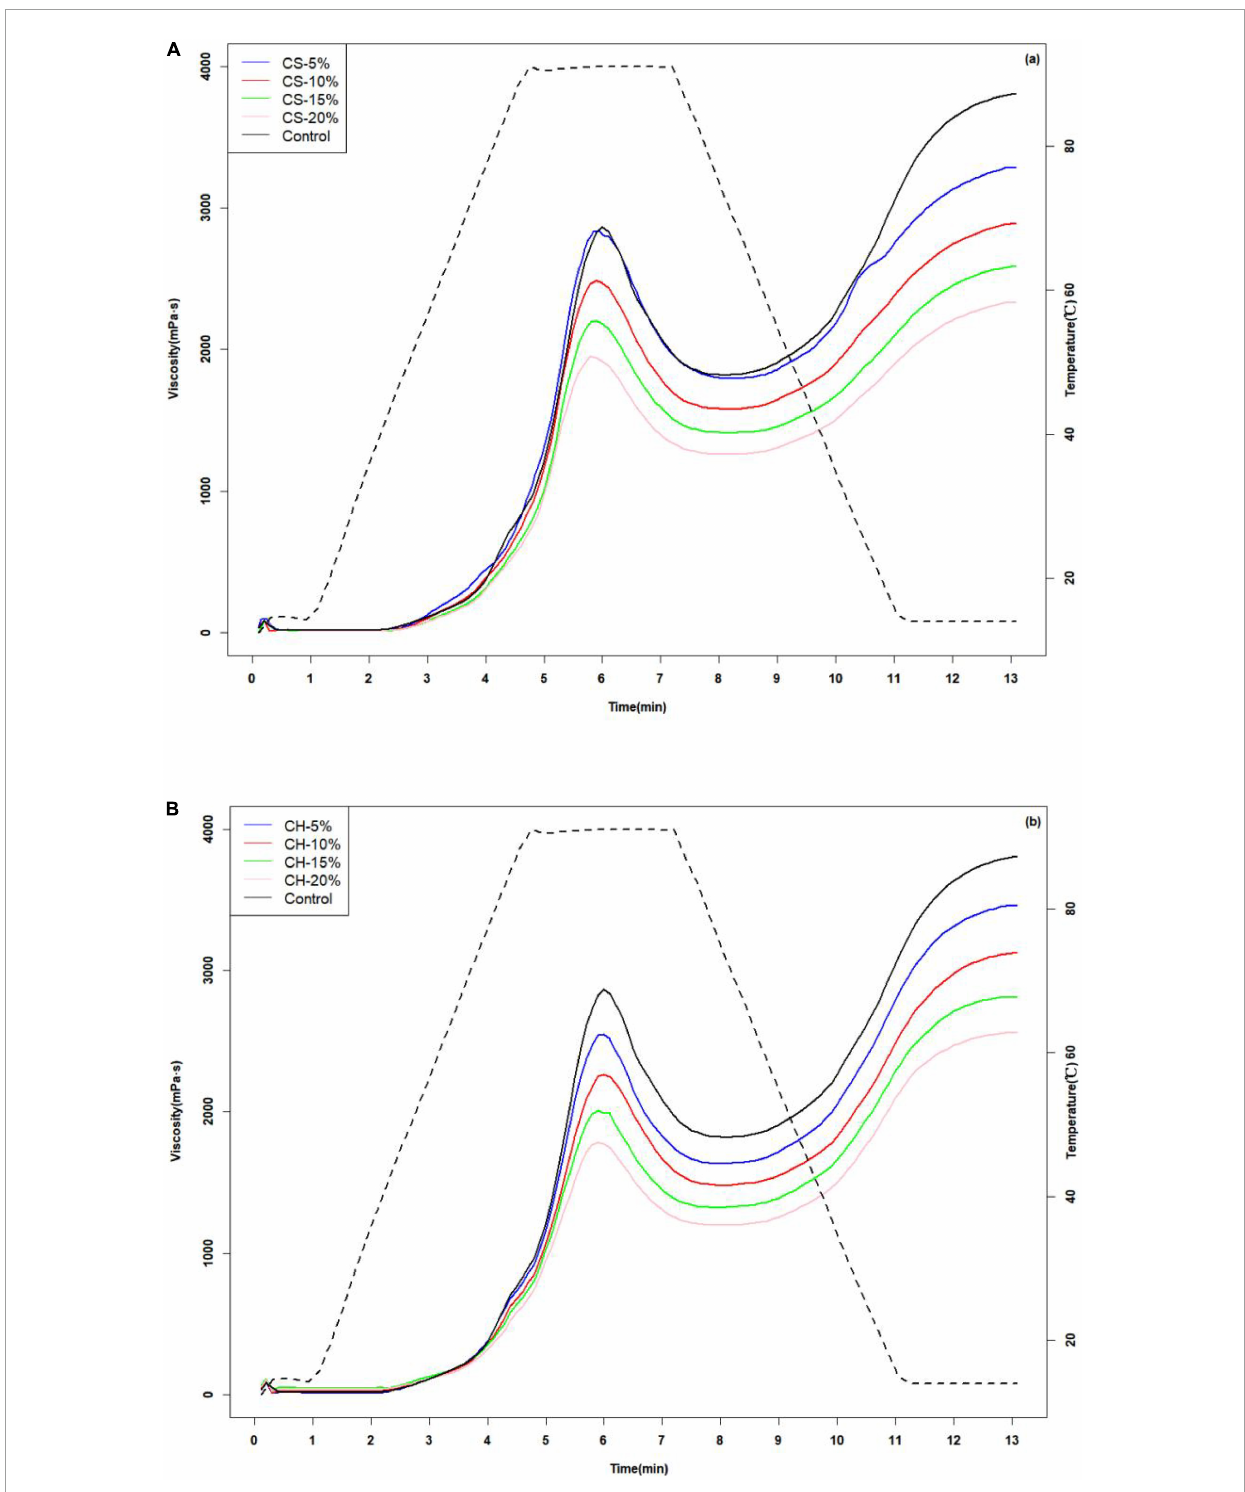
FIGURE1 Viscosity changes of CS-flour mixtures at different mixing ratios (CS/flour mixture = 0, 5, 10, 15, and 20% w/w) (A) and CH-flour mixtures at different mixing ratios (CH/flour mixture = 0, 5, 10, 15, and 20% w/w) (B) .